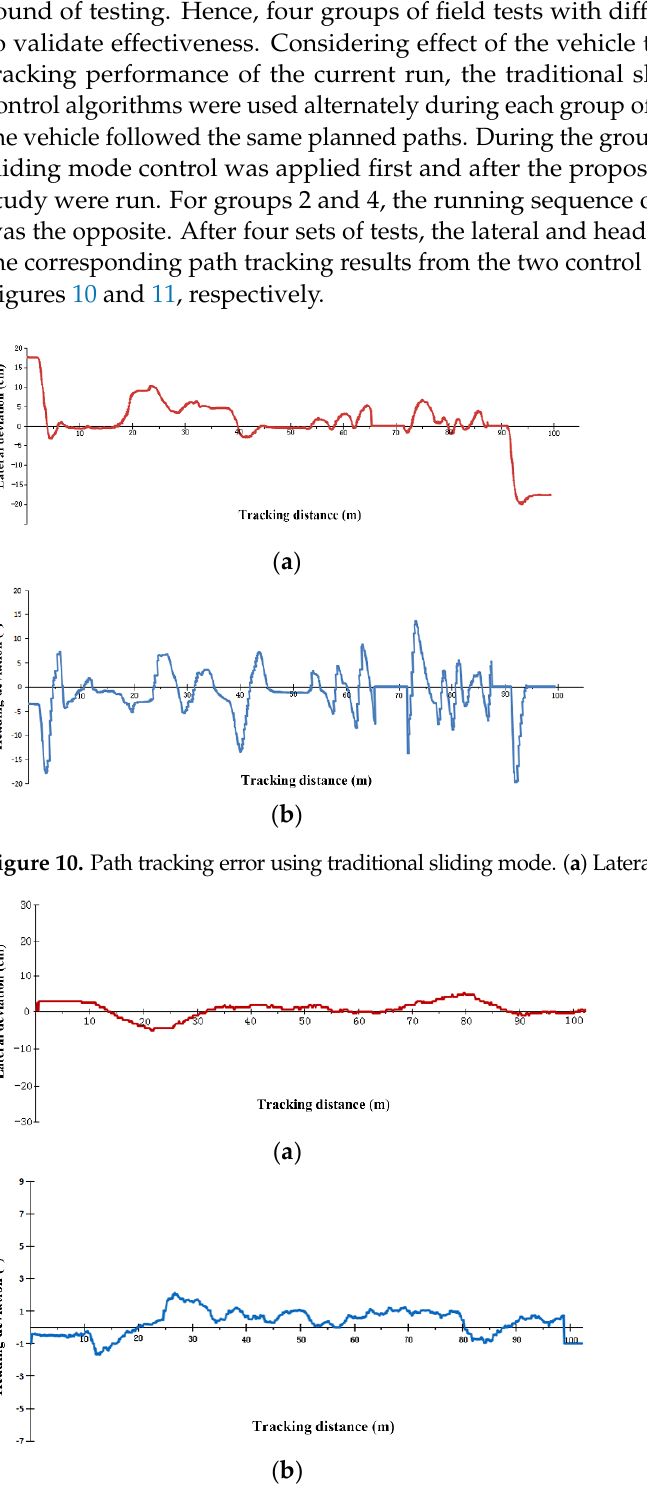
Figure 9. Experimental platform and Path tracking test. ( a ) Test platform; ( b ) field experiment.